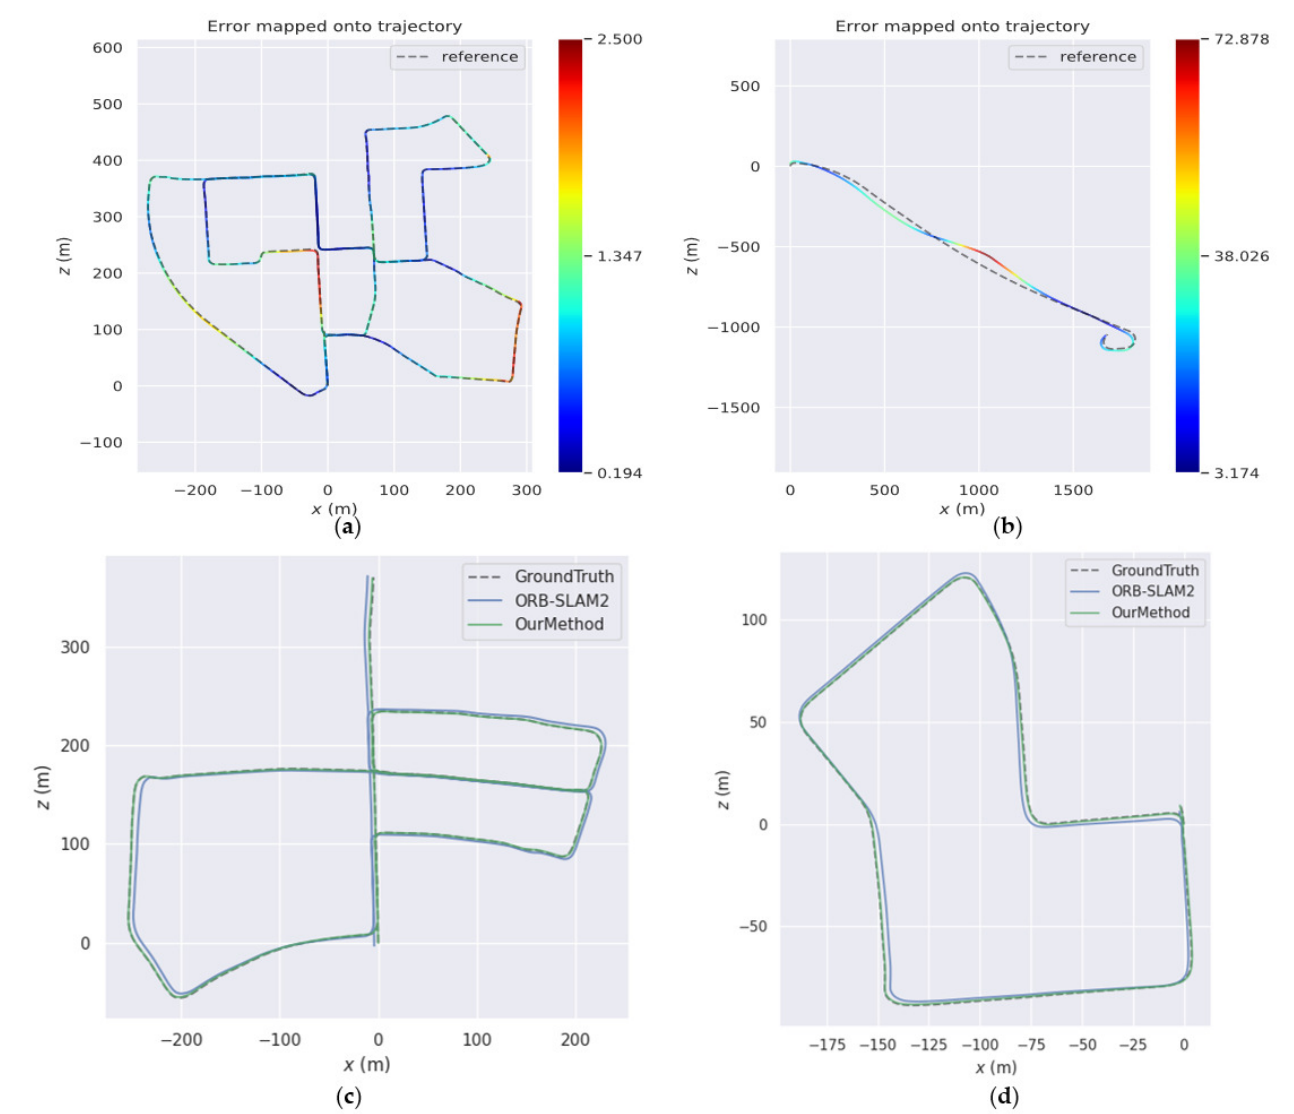
Figure 5. Comparison of estimated trajectories with ground truth in different sequences. ( a ) Compar- ison in sequence 00, ( b ) comparison in sequence 01, ( c ) comparison in sequence 05, ( d ) comparison in sequence